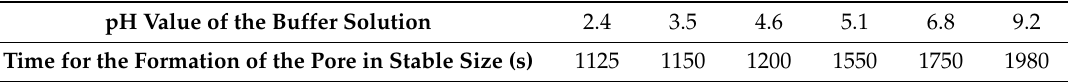
Table 1. Equilibrium time of the pore size at different pH values.